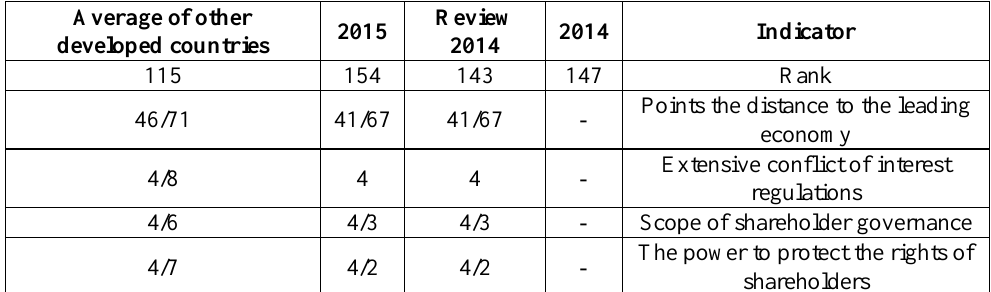
Table 1. The situation of Iran in the shareholder protection index (World Bank,